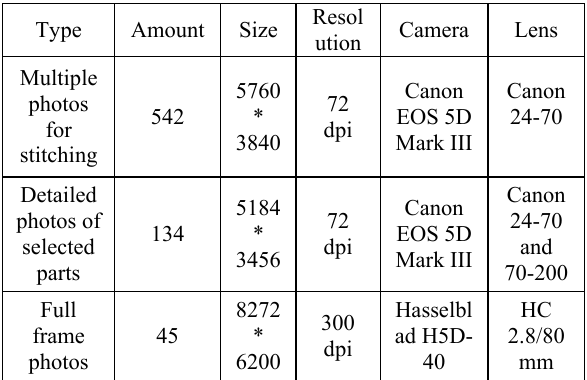
Table 1. Information of digital mural